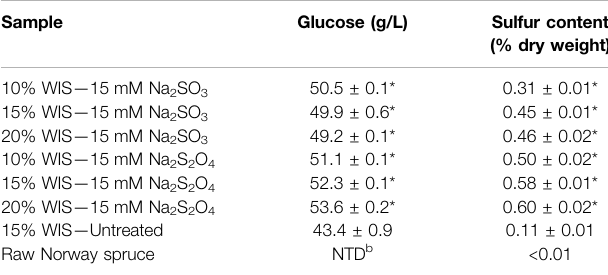
TABLE 4 | Released glucose after 72 h of analytical enzymatic sacchari fi cation of buffered reaction mixtures containing 50 mg of pretreated solids originating from slurries conditioned with sodium dithionite or sodium sul fi te, and sulfur content of solid fractions.